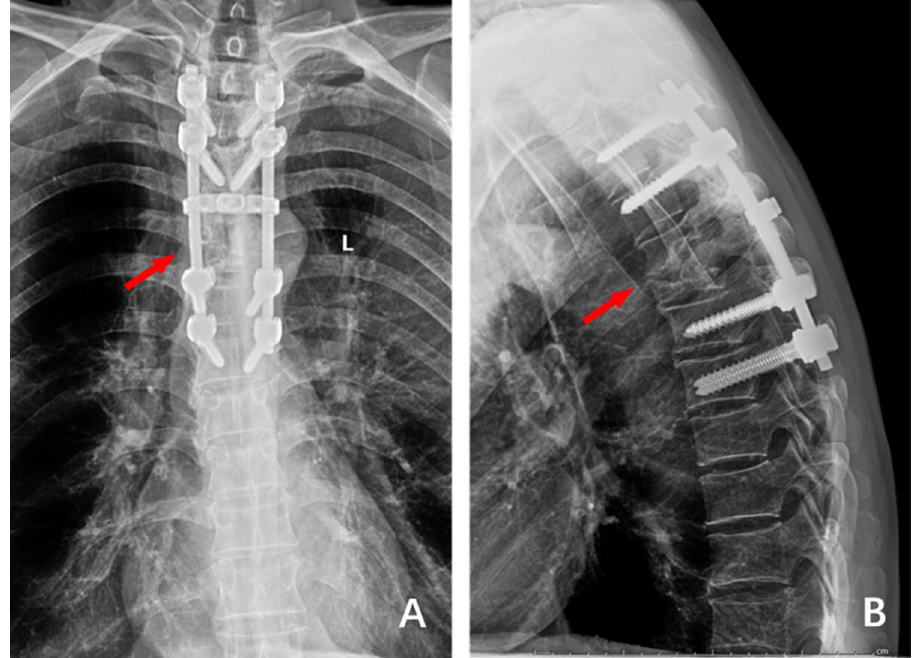
Figure 2. ( A ) and ( B ) 1 week after the operation, the frontal and lateral X-ray films showed that the internal fixation position was good, the deformity was corrected well, and The Cobb Angle was 19°.